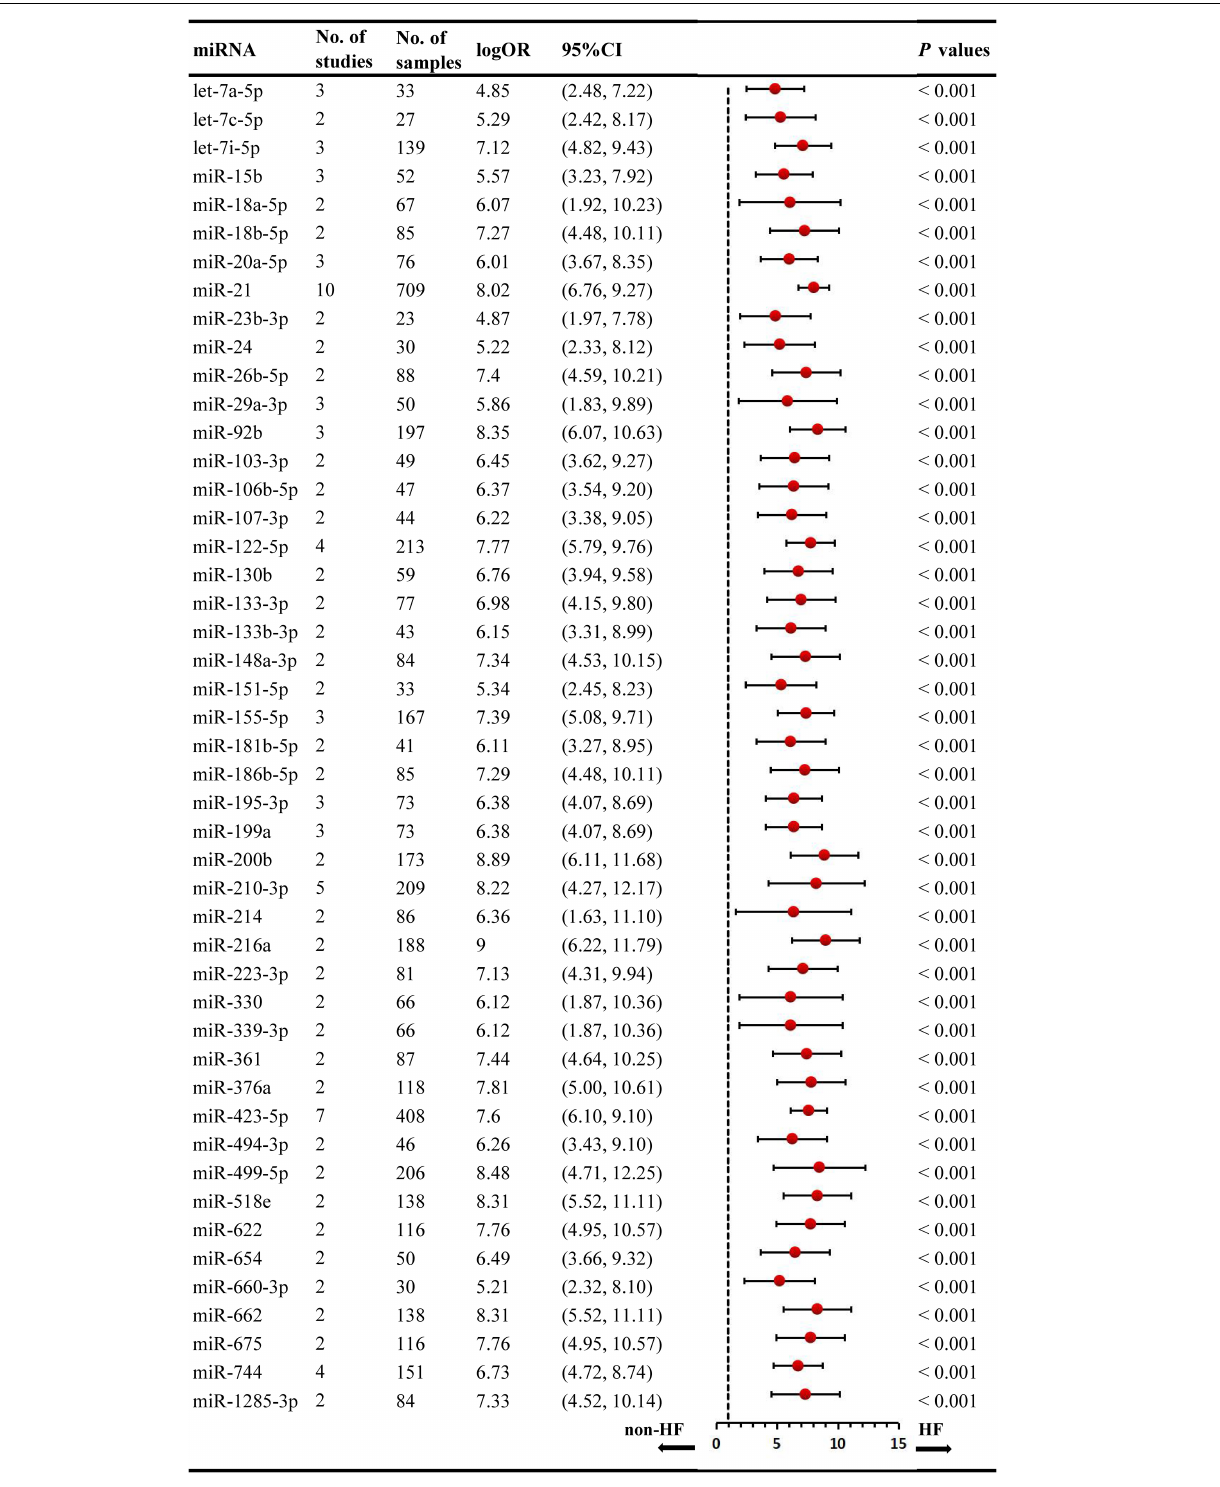
Frontiers in Cardiovascular Medicine |